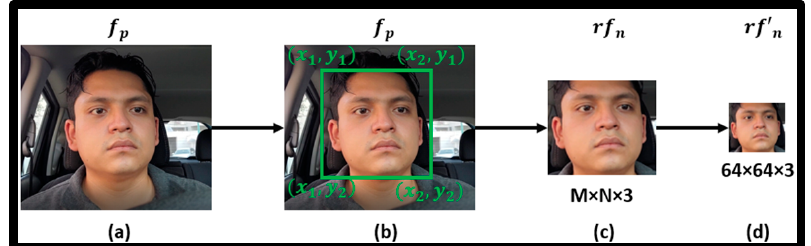
Figure 5. Detection process, fragmentation, and resizing of the driver’s face. ( a ) denotes the input frame, ( b ) shows the detected face, ( c ) shows the segmented face and ( d ) the decimated face image.